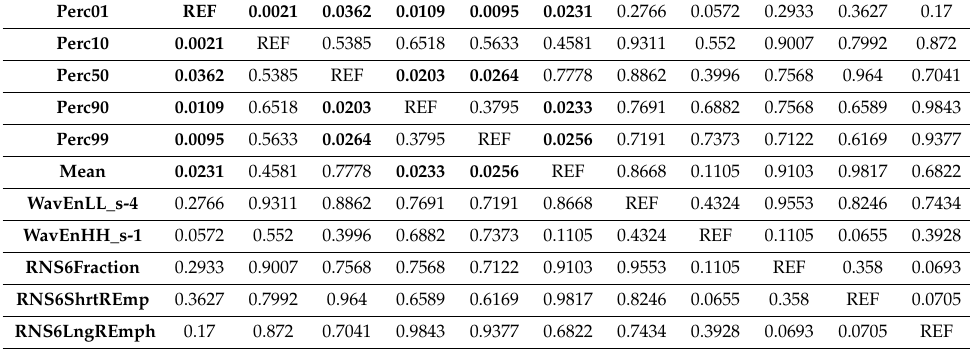
Table 4. Comparison of ROC curves in the differentiation of high-grade gliomas from brain metastases. Numbers represent p -values. Each p -value column represents the comparison between all parameters and the reference one (REF). Values in bold are statistically significant.